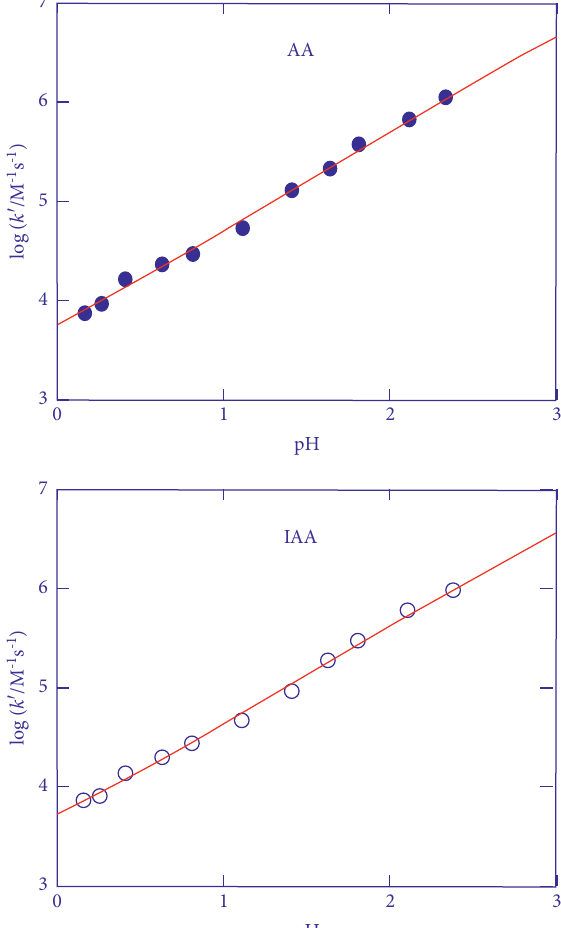
Figure 4: Second-order rate constants k ′ (in logarithmic scale) versus pH plots at 25.0 ° C and 1.0M ionic strength (data points) for reduction of [IrCl 6 ] 2– by AA and IAA. The solid lines represent the best fits of equation (6) to the experimental data by use of a weighted nonlinear least-squares